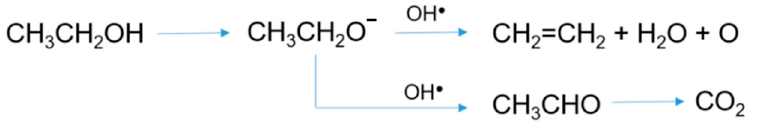
Figure 2. Possible ethanol photocatalytic degradation pathways on the bimetallic catalyst.